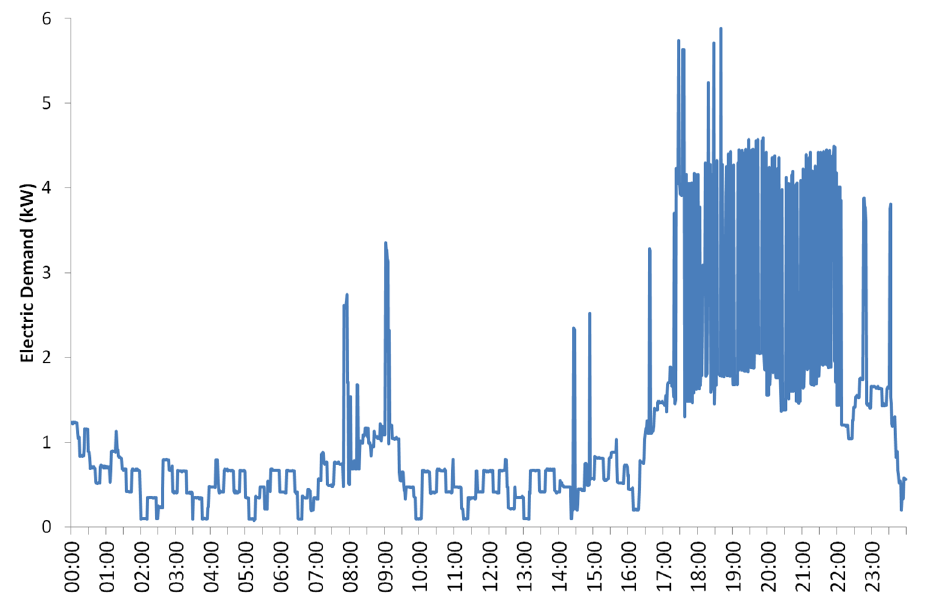
Figure 4. Example of an individual dwelling demand profile at minutely resolution taken from an empirical dataset [24].